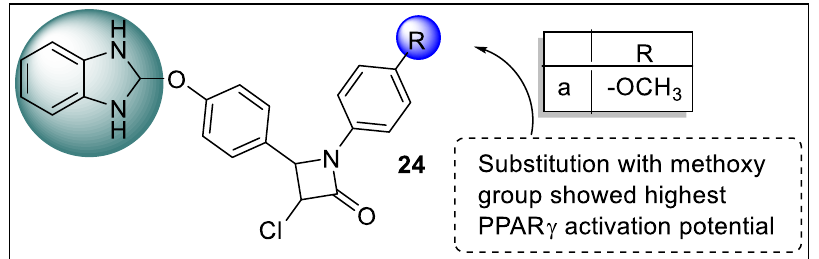
Figure 27. Structural activity relationship of Benzimidazole hybrids ( 24 ) as potent PPAR ligands.